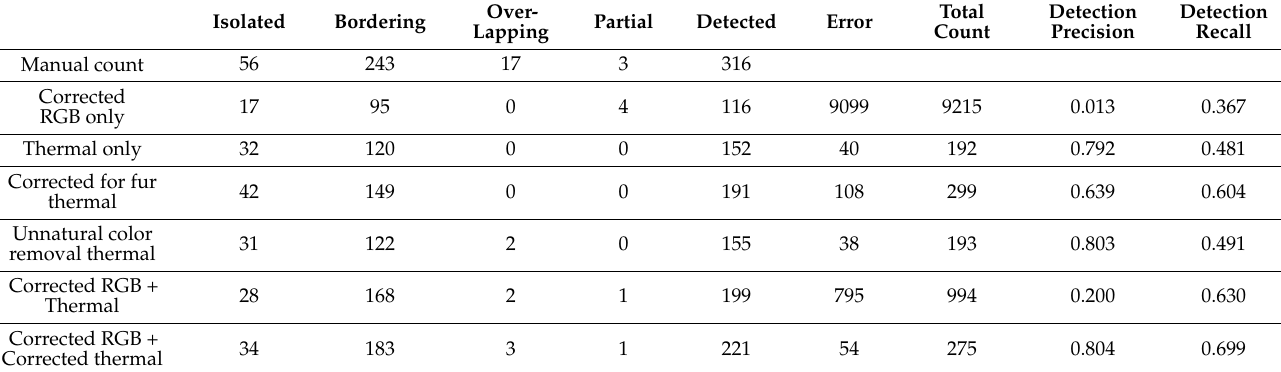
Figure 11. Detection results by height and type of input image. Table 1. Total numbers of targets detected and the detection precision and recall rates (for images with a shooting height of less than 100